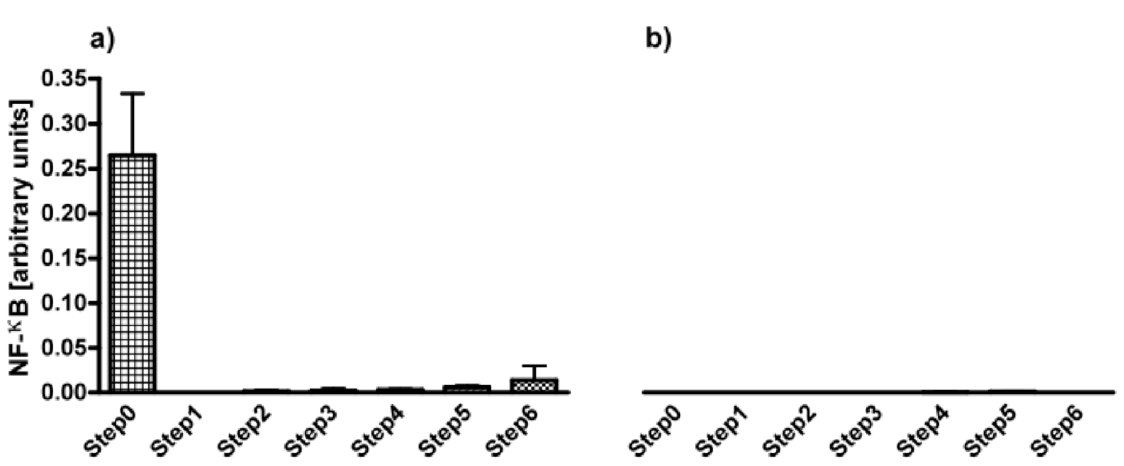
Figure 2. ( a ) Activation of NF-κB in THP1 reporter cell line to determine the immunostimulatory capacity of alginate in the six different steps of purification. ( b ) This activation was completely MyD88 dependent as it was not present in THP1 cell-line that has a non-functional MyD88. Activation of NF-κB was almost completely gone after the first steps of purification. Values are presented as mean ± SD ( n = 5). All the purification steps presented a statistically significant response ( p < 0.001) when compared with crude alginate (step 0) or with purified alginate (step 6). LPS (1 µg/mL) was used as positive control for the THP1-cell line, and induced an activation of NF-κB of 1.039 ± 0.081. For the THP1 cell line presenting a MyD88 non-functional protein, Tri-DAP (10 µg/mL) was